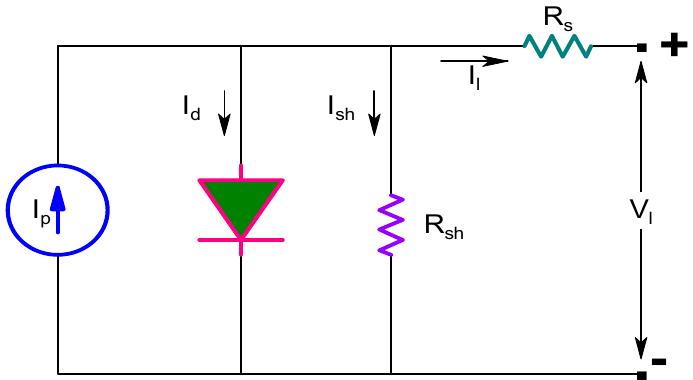
Figure 1. Single diode model of photovoltaic panel module.